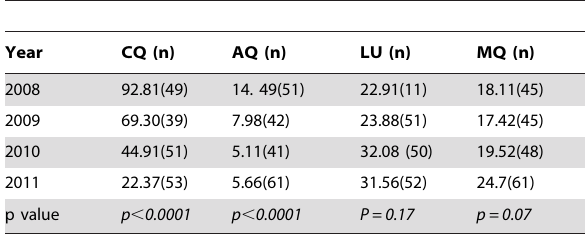
Table 1. Median IC 50s for CQ, AQ, LU and MQ per Year during